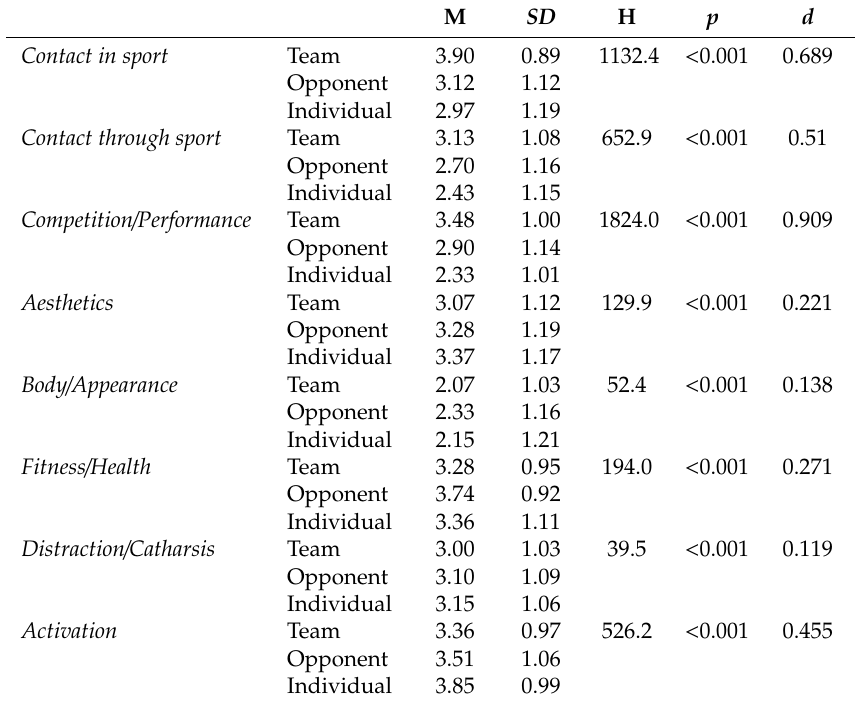
Table 7. Comparison of motive mean values across sport / exercise